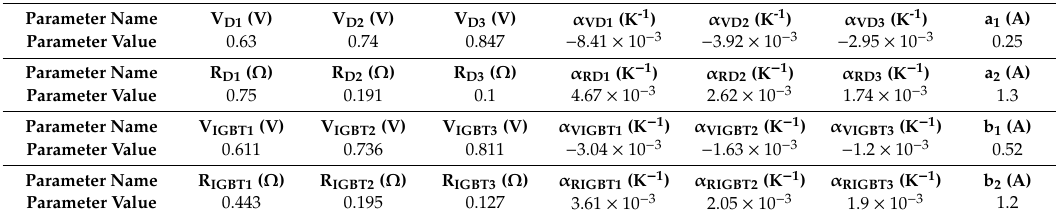
Table 1. Values of parameters of the piecewise linear model of the used insulated gate bipolar transistor (IGBT) and diode.